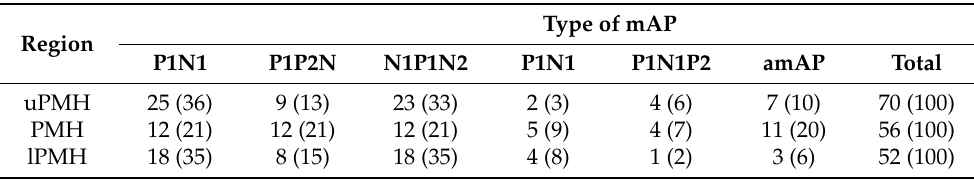
Table 1. Absolute frequency and percentage (between brackets) computed for the different types of mAP at the three regions.